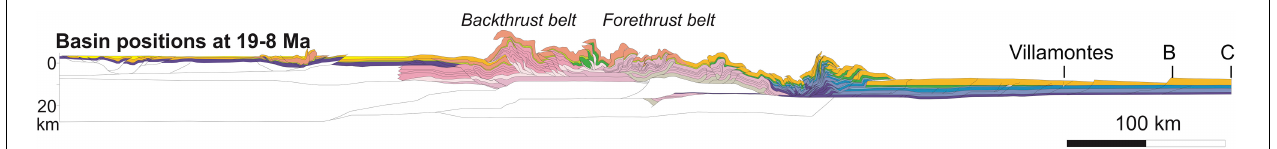
FIGURE 3 | Partially restored balanced cross section showing the positions of stratigraphic sections at Villamontes, and positions B and C, which were used in the flexural modeling. Modified from Anderson et al. (2018).